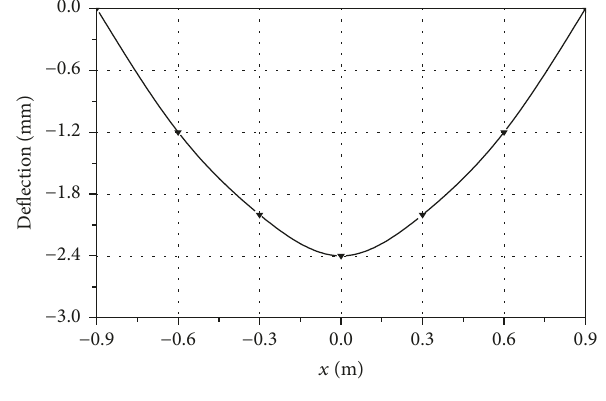
Figure 5: Slab deflection.